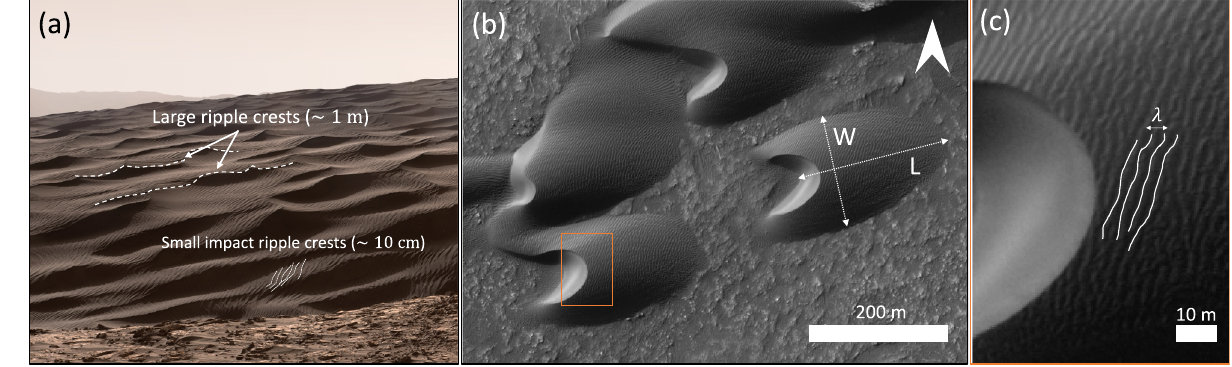
Fig. 1 | Dunes and ripples on Mars. a Impact ripples superimposed on large wind ripples atop Namib dune, Gale Crater, Mars. (Curiosity rover Mastcam mosaic; credit: NASA/JPL-Caltech/MSSS/Thomas Appéré). b Large ripples